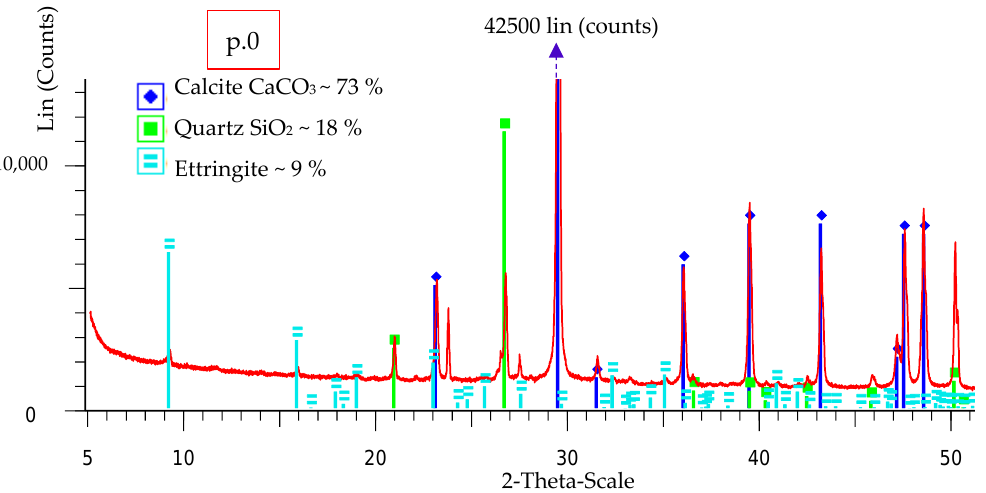
Figure 4. The X-ray phase analysis diffraction test of self-destructed lime mortar with 30% fluidised bed ash, F30.